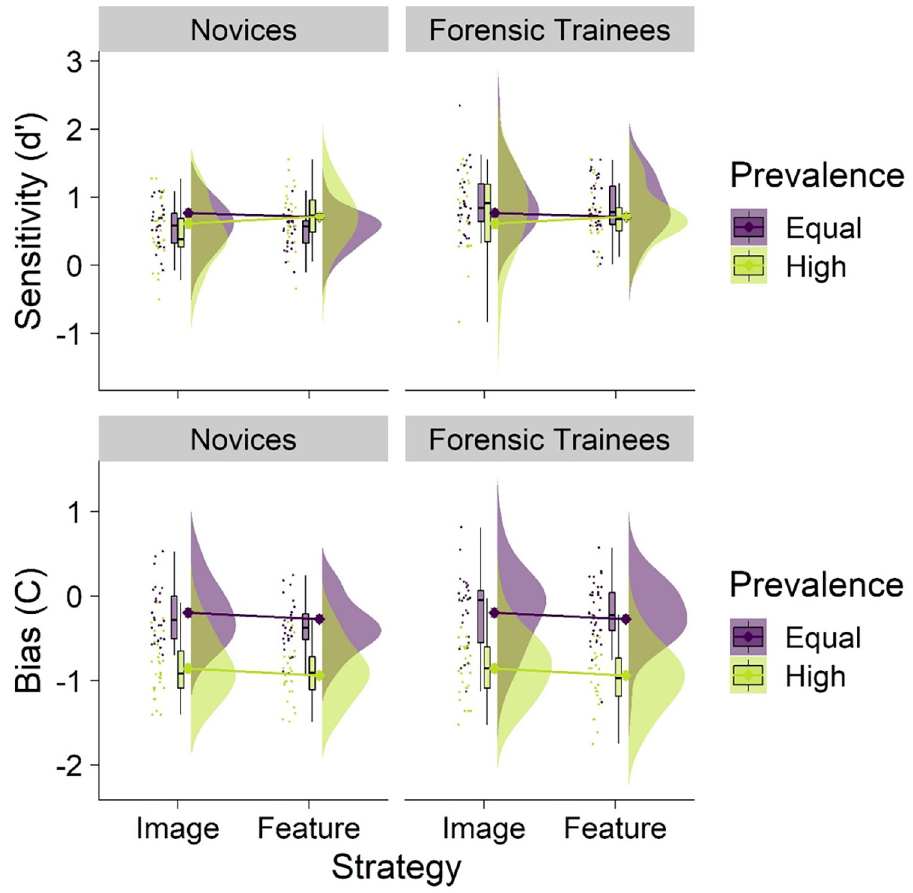
Fig 4. Sensitivity (top panel) and response bias (bottom panel) by prevalence, strategy conditions, and group. Raincloud plots depict (left-to-right) raw jittered data points, box-and-whisker plots, means (represented by diamonds) with error bars representing ± 1 SE , and frequency